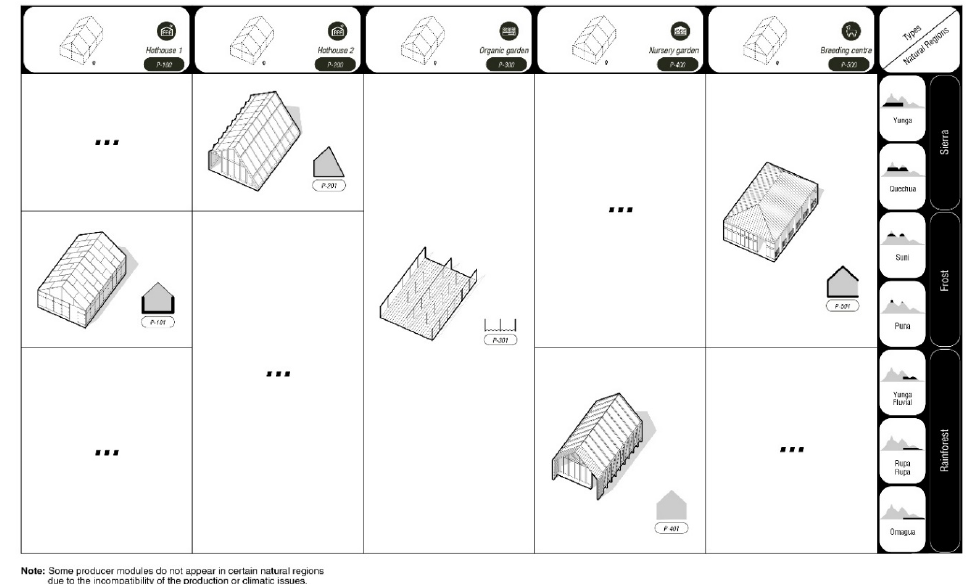
Figure 14. The systematic catalog: producer modules (source: